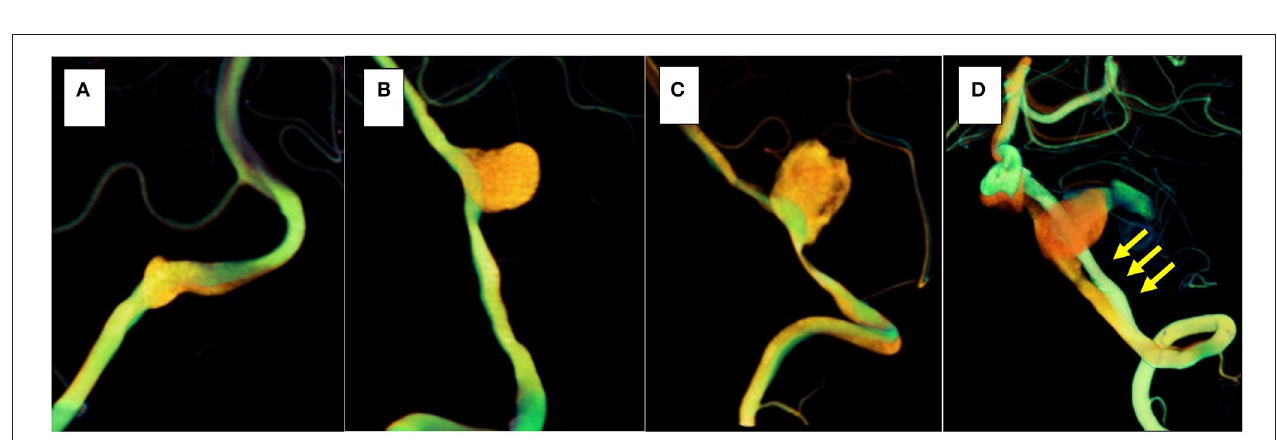
FIGURE 5 | In the case 4, the patient presented with vertigo and left hemifacial spasm. The brain stem was compressed by a giant partially thrombosed vertebral artery aneurysm. (A–C) Overlapping stents with triple low-profile visualized intraluminal support (LVIS) were placed (three of 4.5 × 32mm), and stagnation of flow occurred soon after treatment. Her symptoms were resolved. (D) After 1 year, the follow-up angiography showed recanalization. (E) Additional stents with double LVIS were placed (4.5 × 18mm, 4.5 × 23mm). (F) However, it was uncontrollable and further recanalization was seen in the 6-month follow-up angiography (G) ; furthermore, progressive aneurysmal enlargement occurred and aneurysm wall enhancement indicating the vasa vasorum was observed [ (H) ; white arrow]. Clinically, she presented vertigo and hemifacial spasm again, and slight hoarseness was apparent.